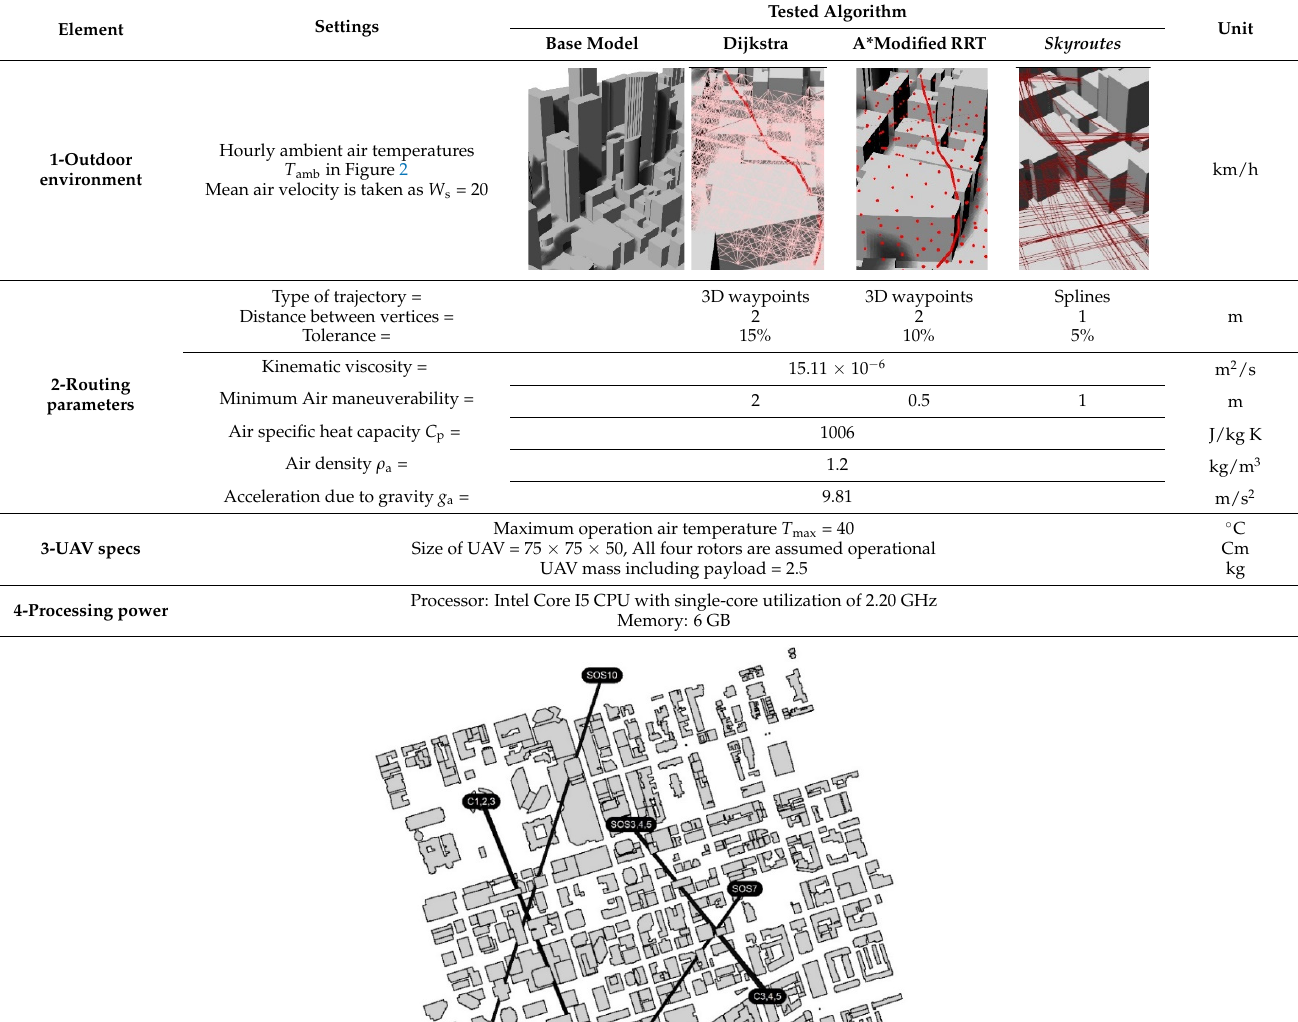
Table 2. Main parameters for simulation missions.